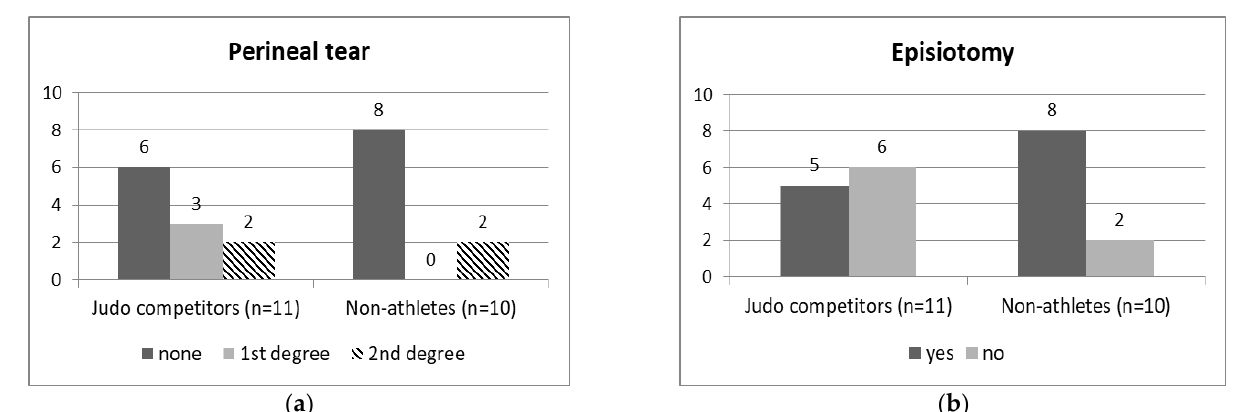
Figure 3. The numbers of ( a ) perineal tears ( χ 2 = 4.39, p = 0.11) and ( b ) episiotomies (Fisher’s exact test: p = 0.11) in in elite judo athletes and non-athlete controls.